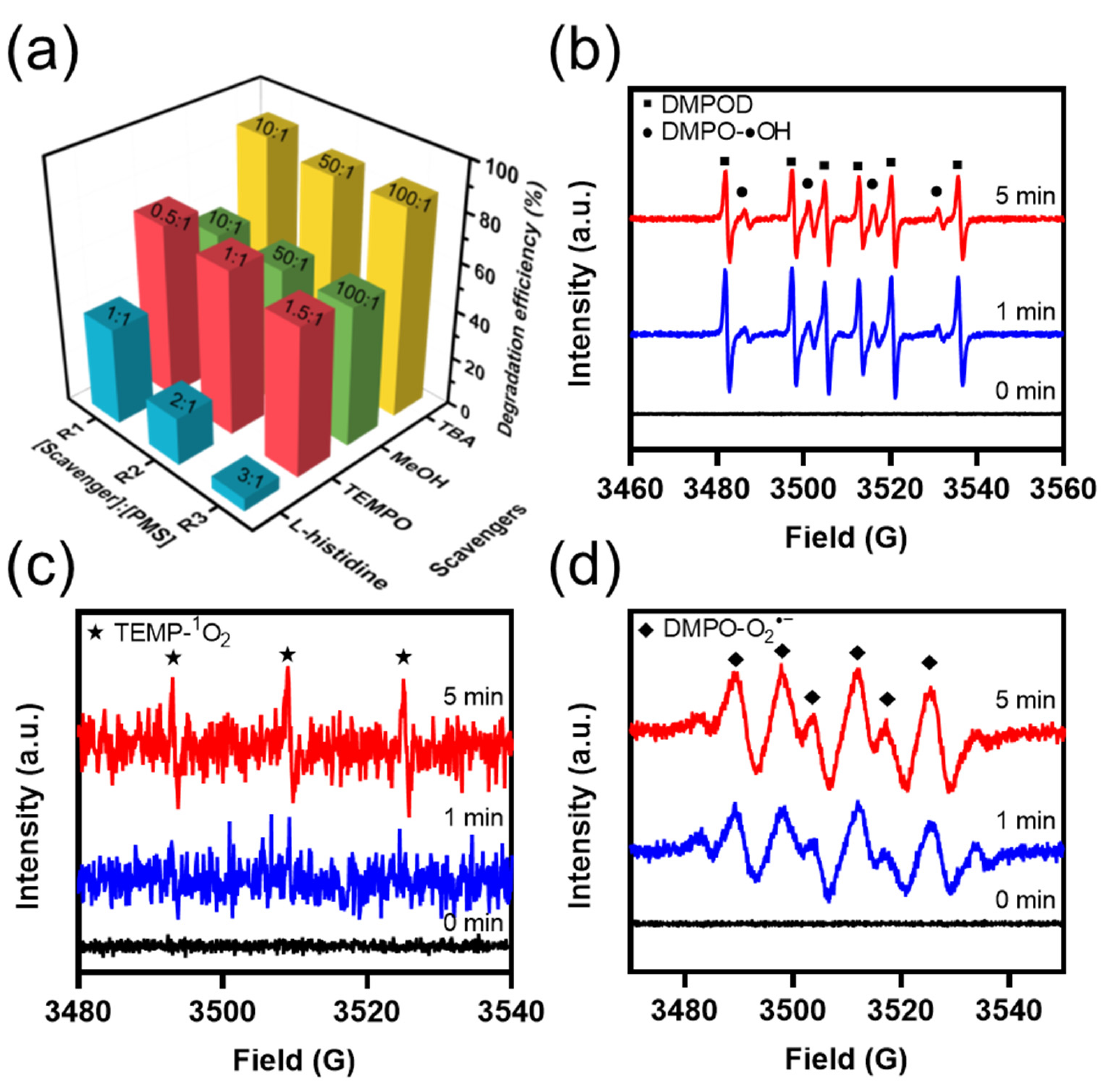
Figure 6. ( a ) Trapping experiments with different scavengers (the molar ratio of scavengers to PMS); EPR spectra for ( b ) • OH and SO 4 •− , ( c ) 1 O 2 and ( d ) O 2 •− .